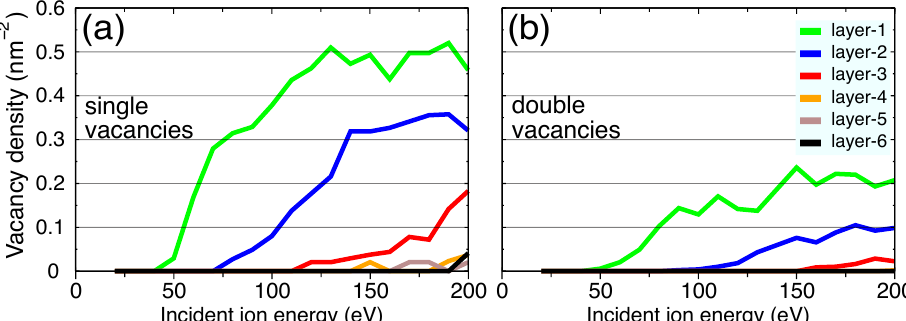
Figure 10. Ion energies for creation of vacancies in h-BN layers. ( a ) Single vacancies; ( b ) double vacancies. The color-code indicates different h-BN layers as shown in the